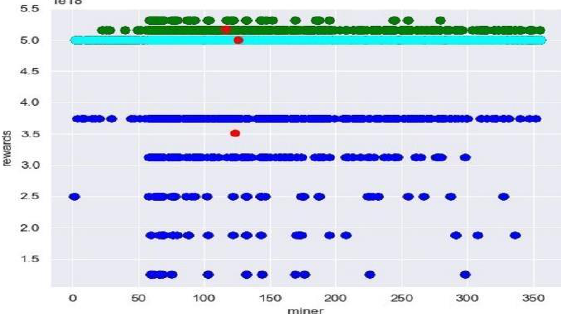
Fig 6. The three clusters.